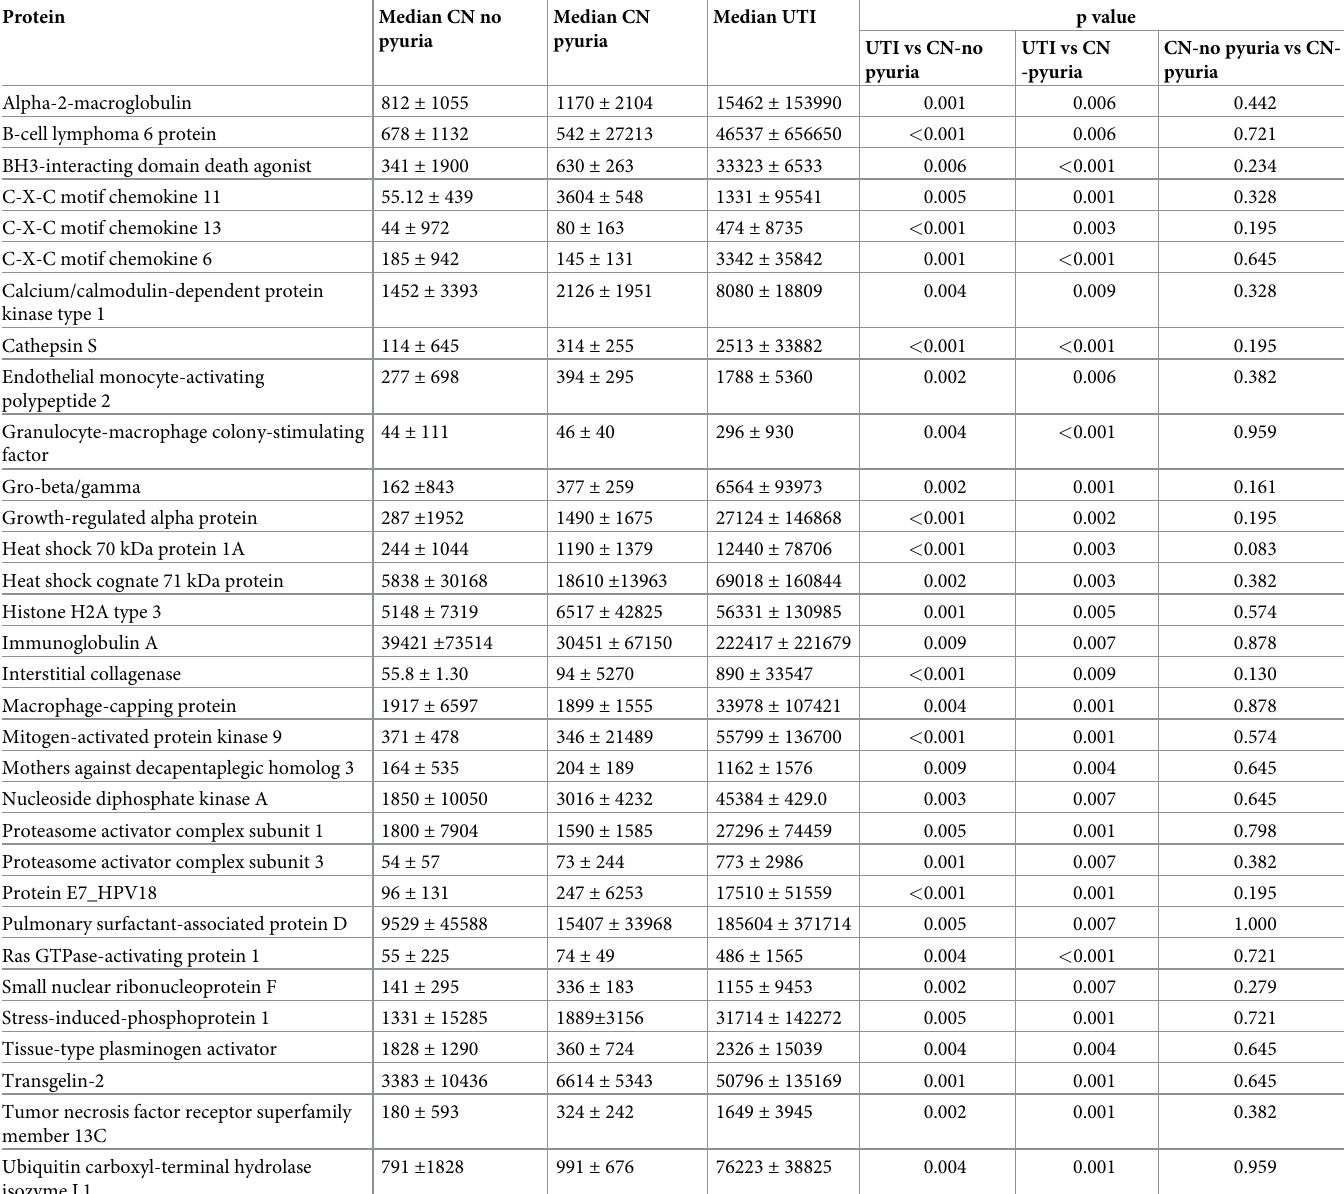
Table 2. Urine biomarker levels (urine biomarker (RFU)/ urine creatinine (mg)). Protein